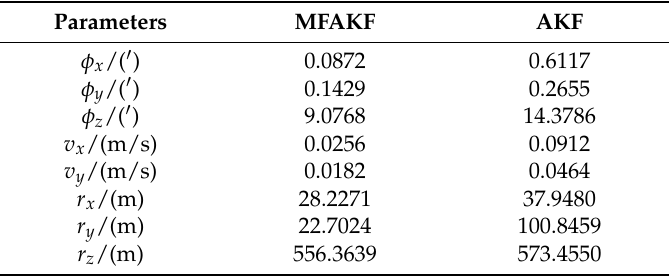
Table 1. RMS errors of SODINS in the simulation.